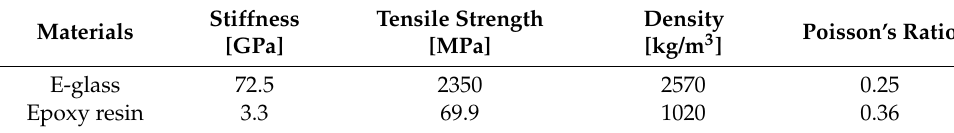
Table 1. Properties of E-glass fiber and epoxy resin